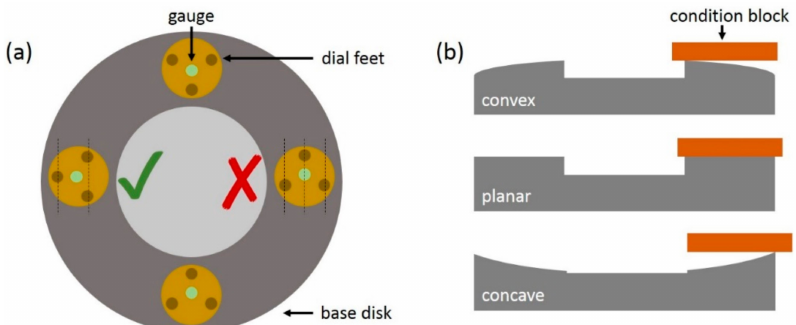
Figure 5. ( a ) Schematic representation of the correct and incorrect positioning of the feet of the precision measurement tool and the four measurement positions for flatness / convexity / concavity on the base disk. ( b ) Indication of the positioning of the conditioning block in the case of inside, center, and outside positioning for respectively convex-, defective-, and concave-disk conditioning.